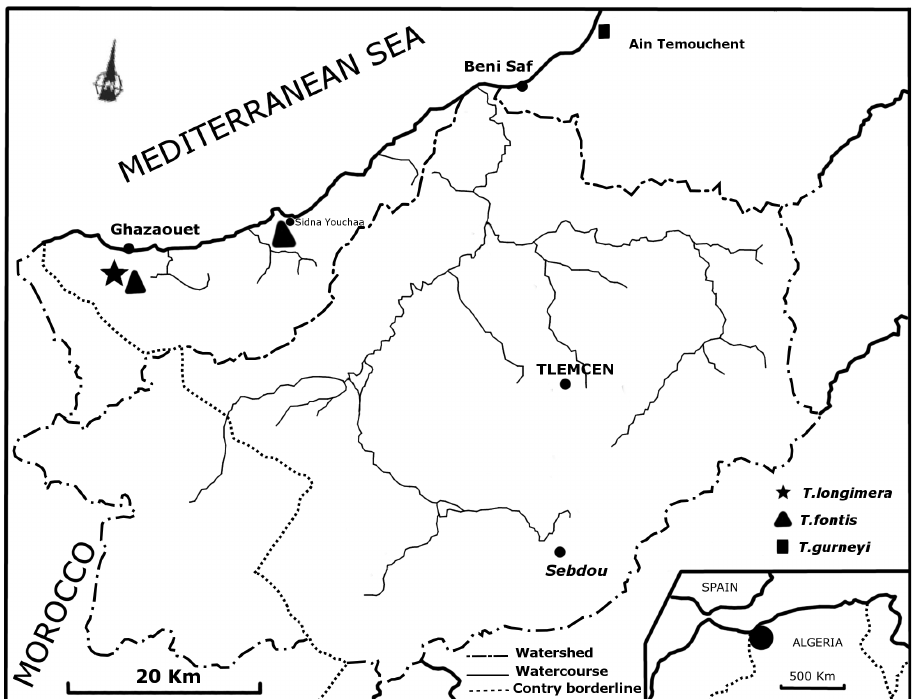
Figure 1. Map showing collection localities of the genus Typhlocirolana from the north-western Algeria. Coll. Crust. 4751; 38 ♂♂ and 129 ♀♀ , MZUF Coll. Crust. 4752; 55 ♂♂ and 2 ♀♀ , same locality and collector, coll.